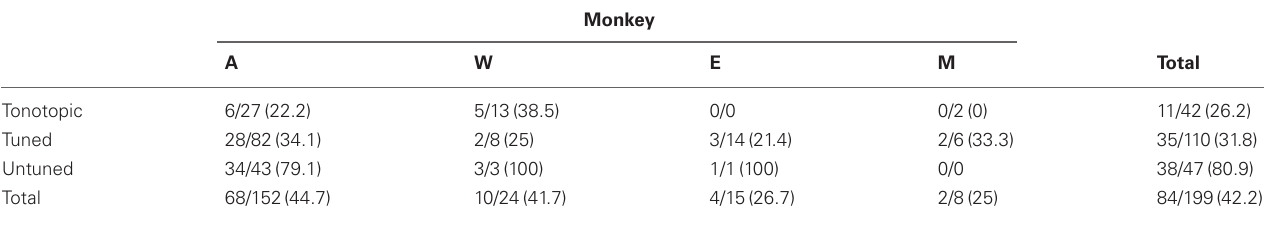
Table 1 | Proportion of visual/visuomotor sensitive sites in functionally defined locations.